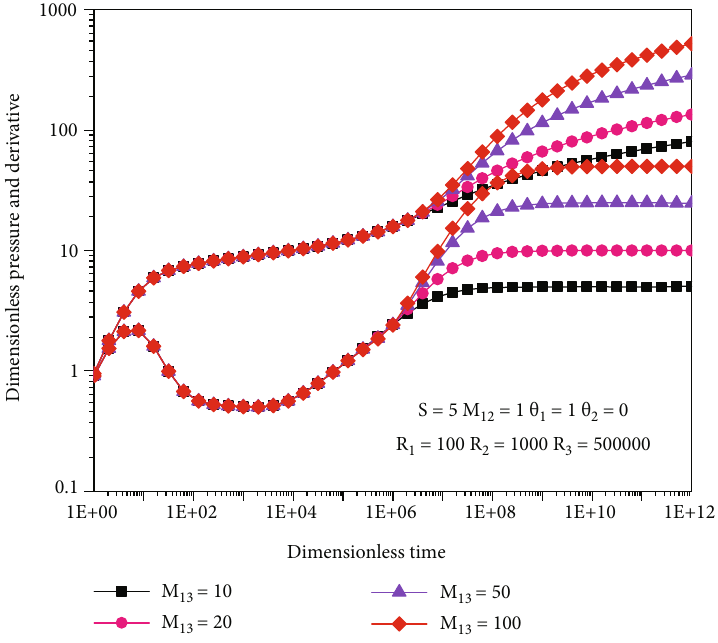
Figure 12: In fl uence of the mobility ratio between the inner and outer zone of the three-zone homogeneous radial composite reservoir on well bottom pressure performance.